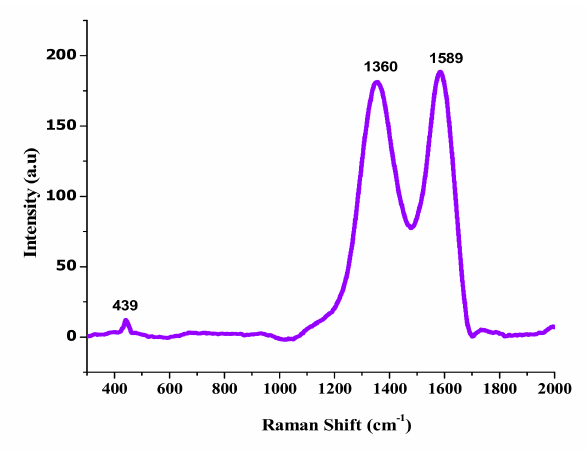
Figure 3. Raman spectra of GO-ZnO nanocomposites.